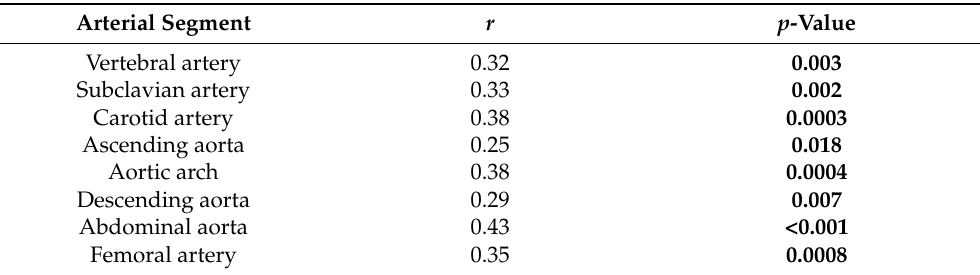
Table 5. Correlations between the vessel wall-to-liver ratio of each arterial segment with C-reactive protein ( n = 87/94).